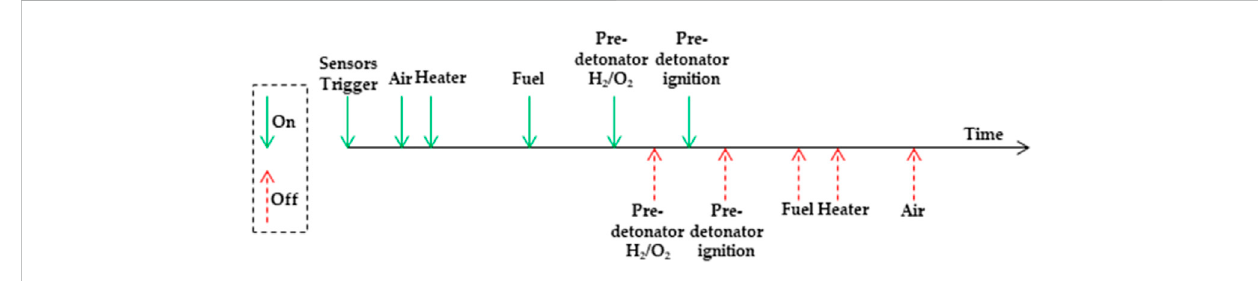
FIGURE 3 Time sequence of the experimental